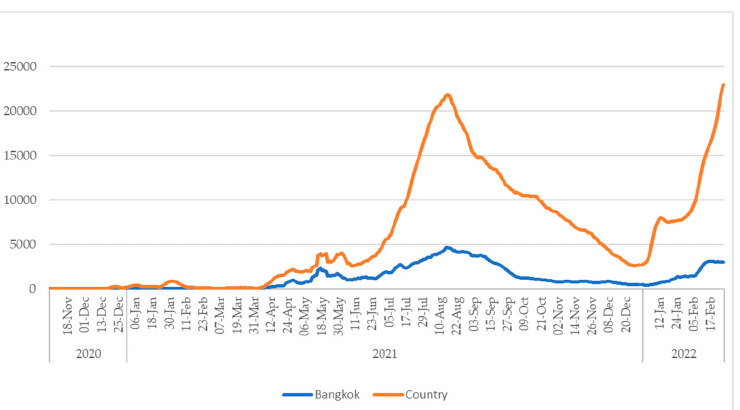
Figure 1. 7-day moving average of the number of daily reported cases of COVID-19 in Bangkok and Thailand from November 2020 to February 2022.